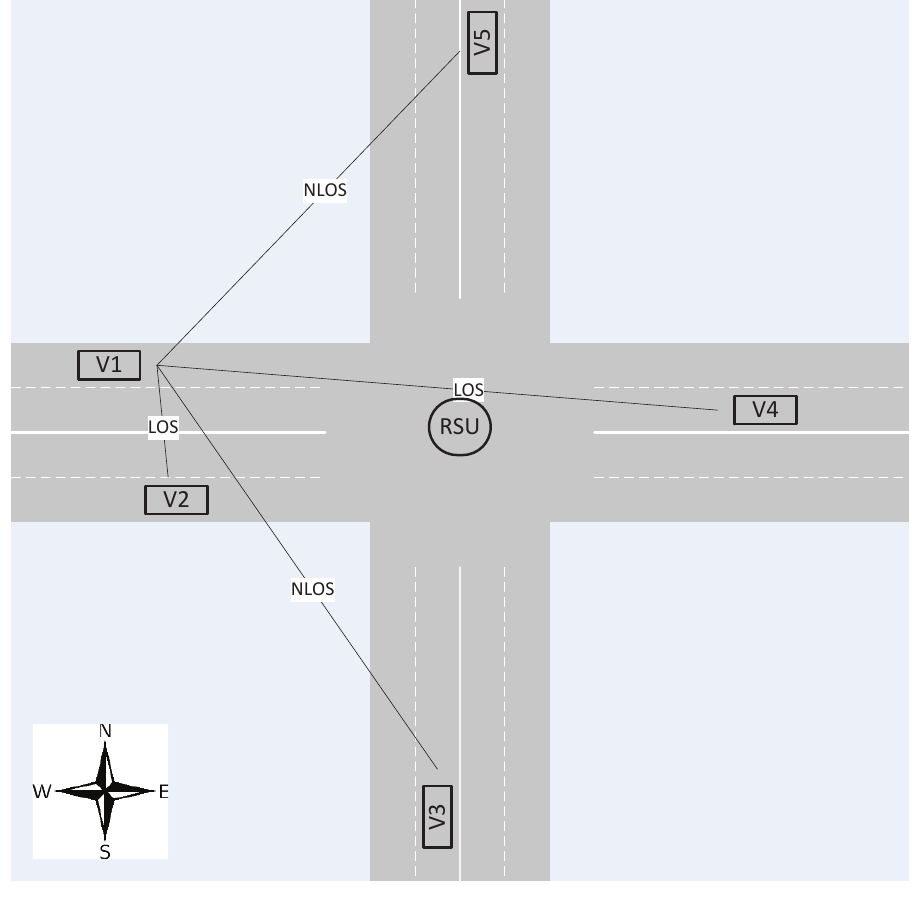
Figure 1. V2X communication at an